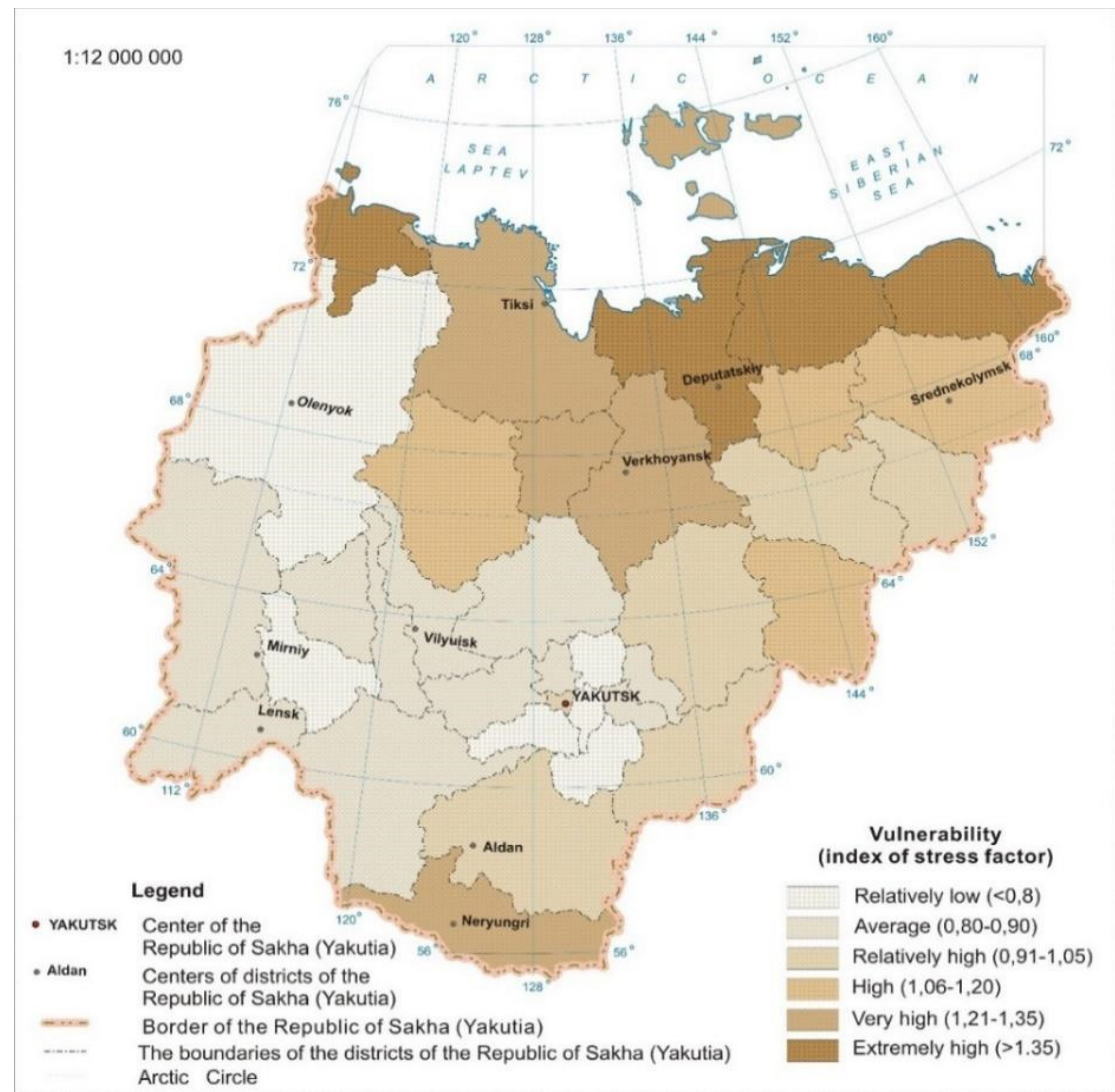
Figure 3. Comprehensive assessment of vulnerability of natural complexes to technogenic